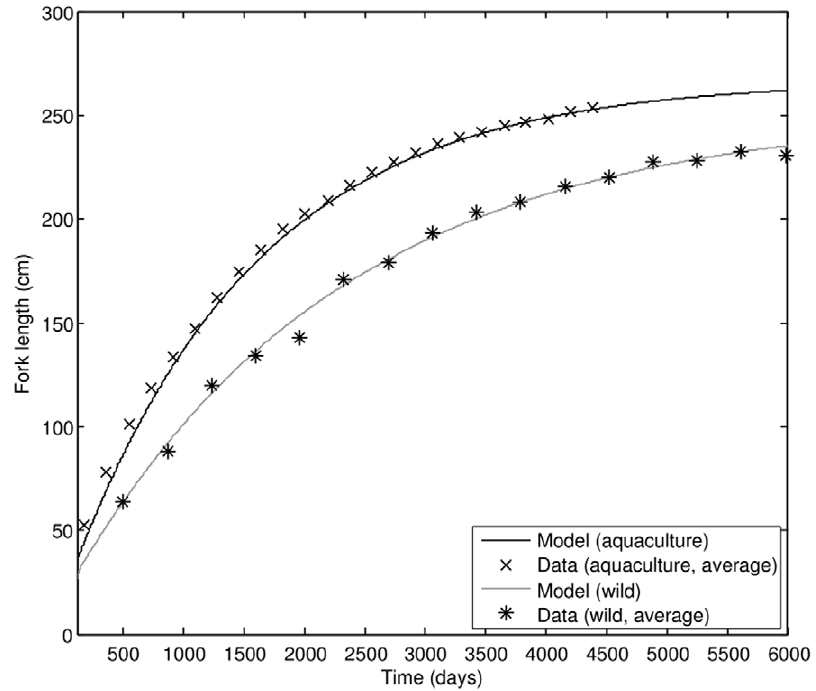
Figure 9. Growth comparison of cultivated and wild PBT (data sources: [ 46,47 ] ).